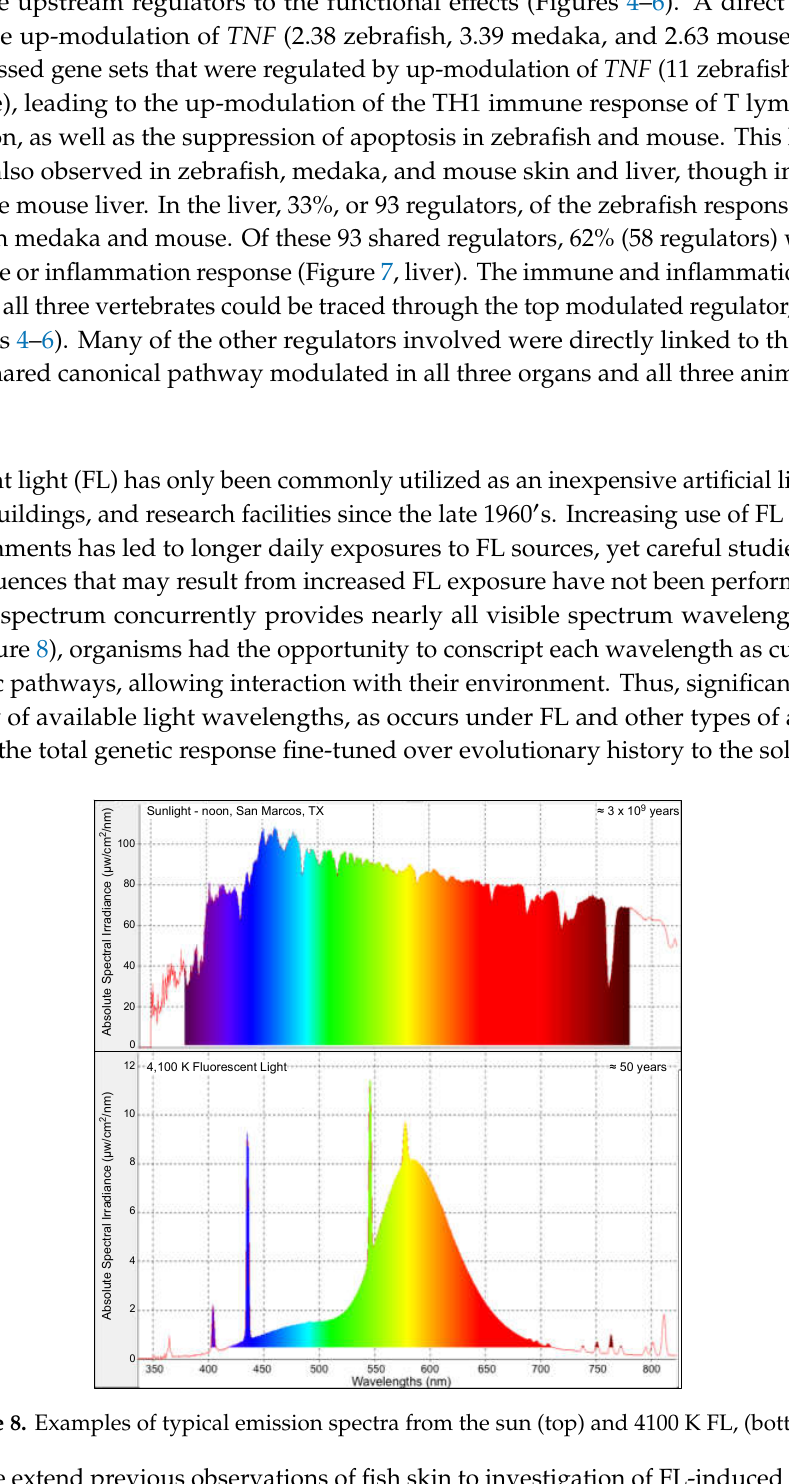
Figure 7. Zebrafish, medaka, and mouse shared up-stream regulators differentially modulated (z-score ± 2) in skin (left), brain (center) and liver (right) following FL exposure. Red represents regulators that are up-modulated in response to FL, and green represents down-modulation as predicted by IPA.